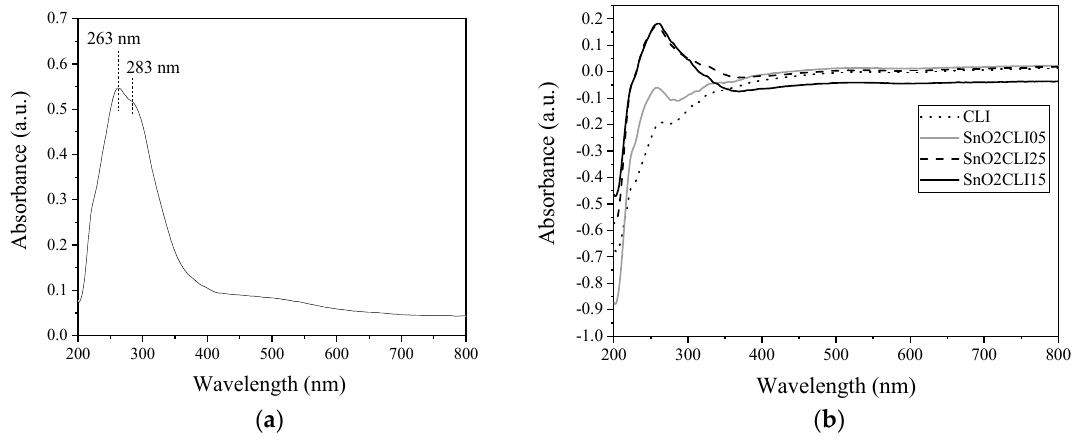
Figure 3. Diffuse reflectance spectroscopy (DRS) UV/Vis spectra of ( a ) SnO 2 and ( b ) clinoptilolite (CLI) and SnO 2 -clinoptilolite CLI.